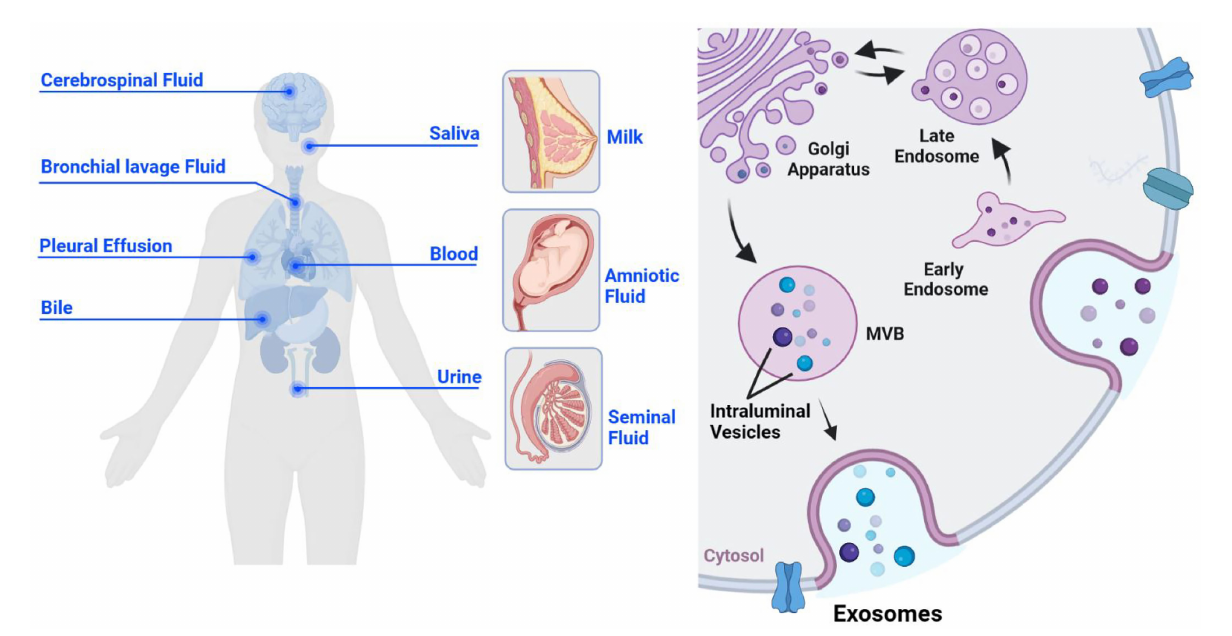
FIGURE 1 The origin and biogenesis of exosomes. Exosomes are derived from cells and are widely present in various body fl uids, such as cerebrospinal fl uid, saliva, bronchial lavage fl uid, pleural effusion, blood, bile, urine, breast milk, amniotic fl uid, and semen (left). Exosomes originate from the inward budding of the cell membrane, undergo early endosomes, late endosomes, and MVBS, and eventually form mature monolayer vesicles, which are secreted to the outside of the cell in the form of the exosome